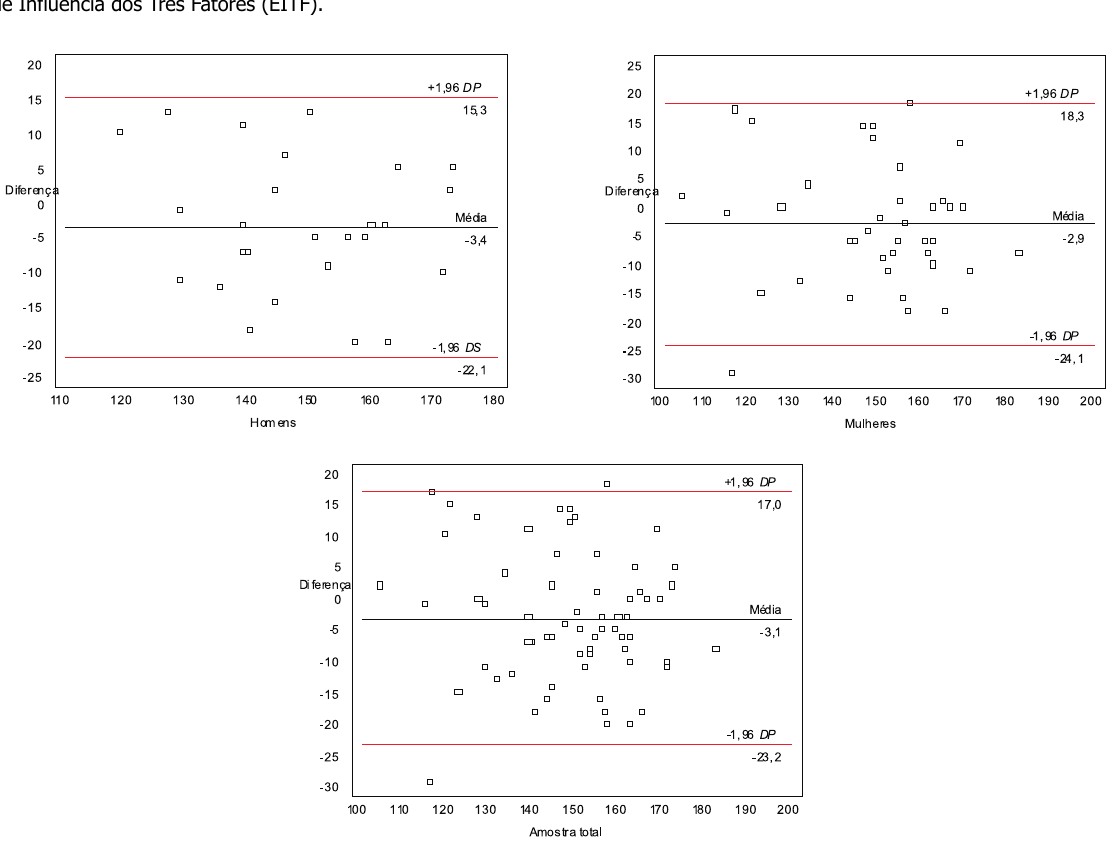
Figura 1 . Distribuição da diferença de médias do escore EITF entre as duas entrevistas para homens, mulheres e total da